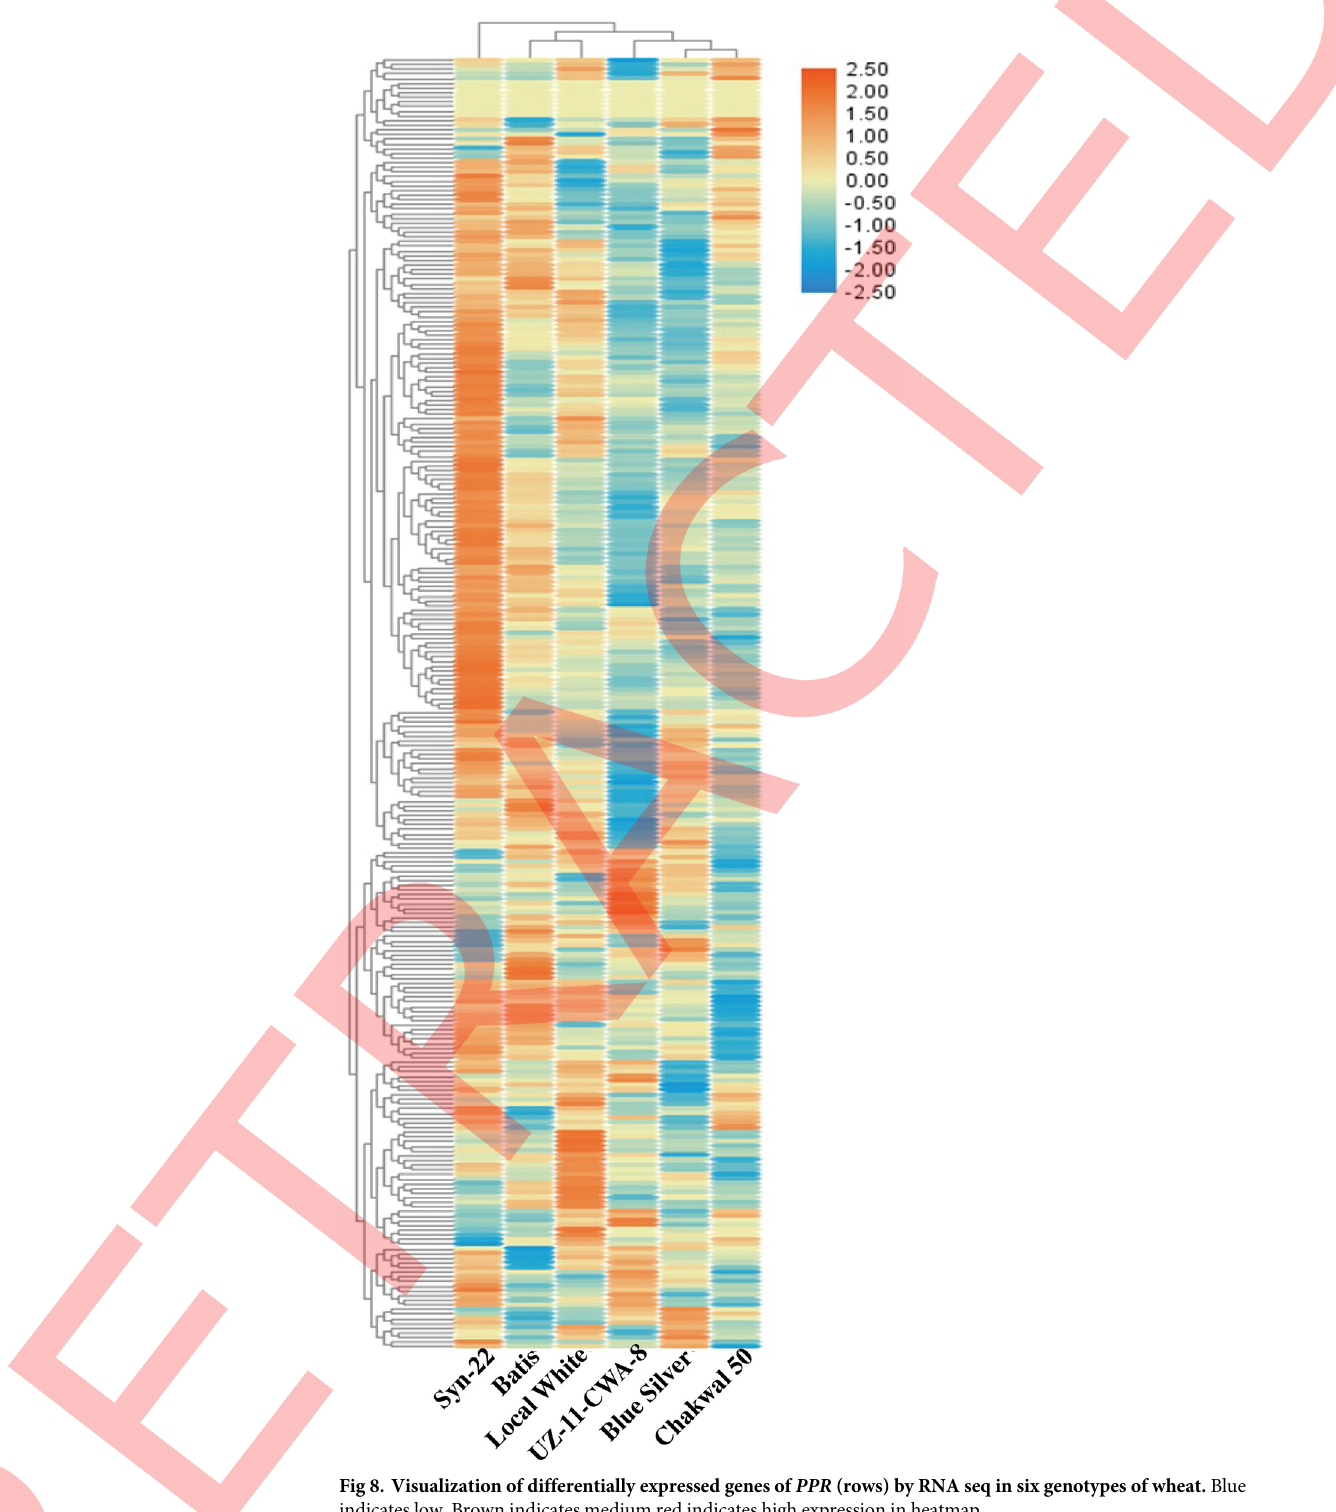
Fig 8. Visualization of differentially expressed genes of PPR (rows) by RNA seq in six genotypes of wheat. Blue indicates low, Brown indicates medium red indicates high expression in heatmap.